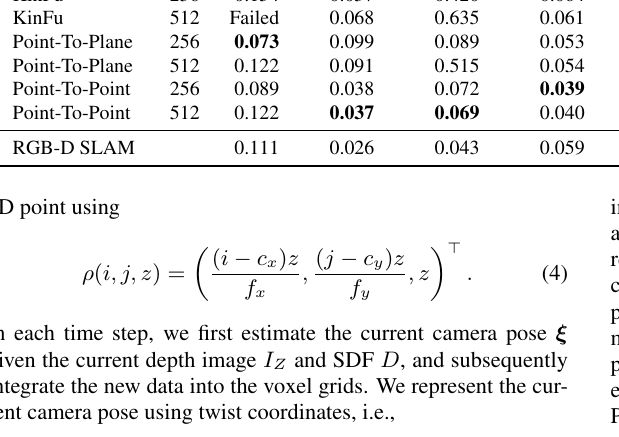
Table 1: The root-mean square absolute trajectory error for KinFu and our method for different resolutions, metrics and datasets. Also the result for RGB-D SLAM are presented. More details on this evaluation can be found in (Bylow et al., 2013). Method Res. Teddy fr1/desk fr1/desk2 fr3/house KinFu 256